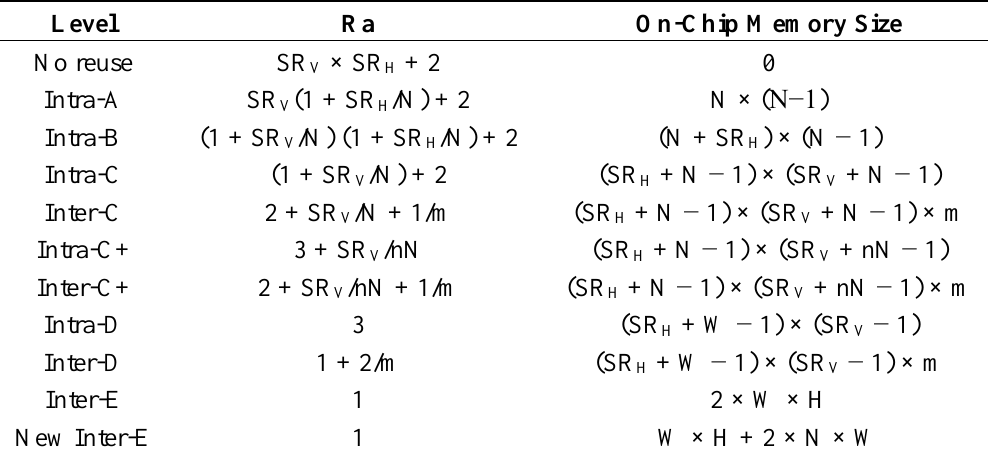
Table 4. Ra and On-chip Memory Size for